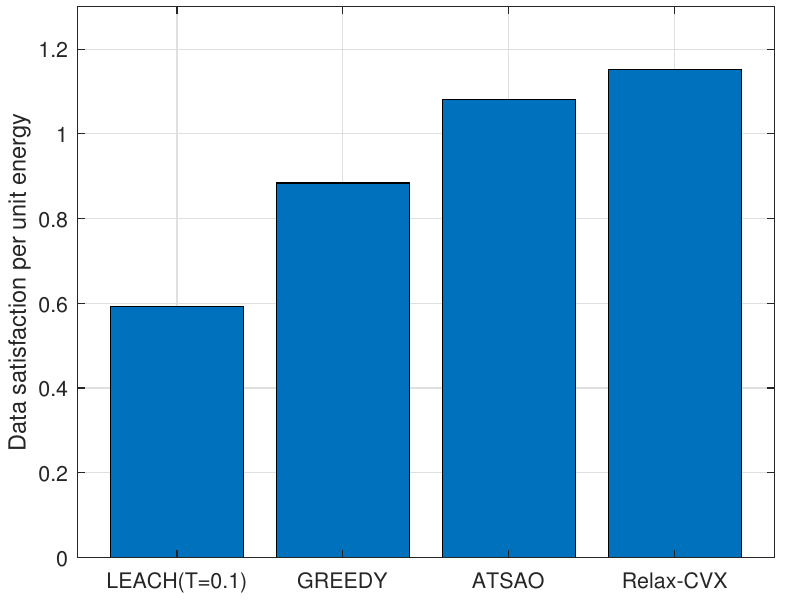
Figure 7. Data satisfaction per unit energy consumption.